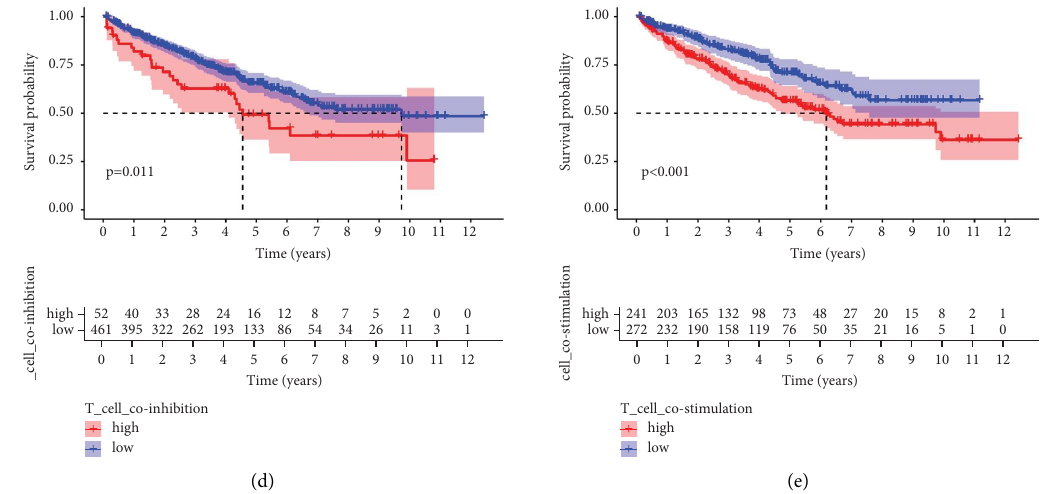
Figure 5: (a) Te correlation between SQDH-based prognostic prediction model of immune-related functions. (b) Te survival analysis between low- and high-HLA groups. (c) Te survival analysis between low- and high-infammation-promoting groups. (d) Te survival analysis between low- and high-co-inhibition T cell groups. (e) Te survival analysis between low- and high-co-stimulation T cell